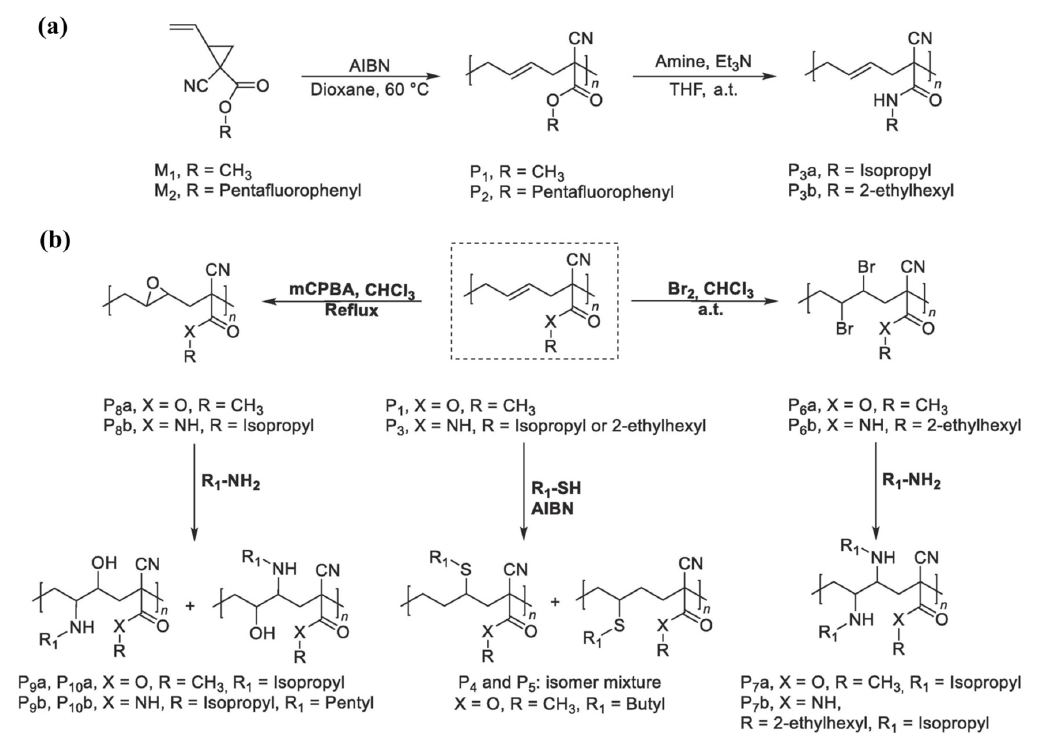
Figure 27. The general scheme presents ( a ): the synthesis of the parent polymers P1, P2, and P3, and ( b ): the bromination, epoxidation, and thiol-ene addition as subsequent post-polymerization modification reactions for the parent polymers, as designed by Ntoukam et al. Reprinted with permission from [93]; published by Elsevier,